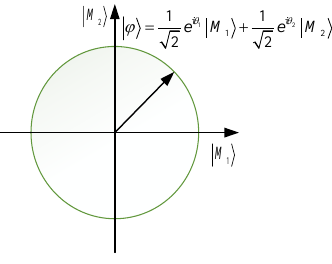
Figure 2. An example of quantum probability in two dimensions.